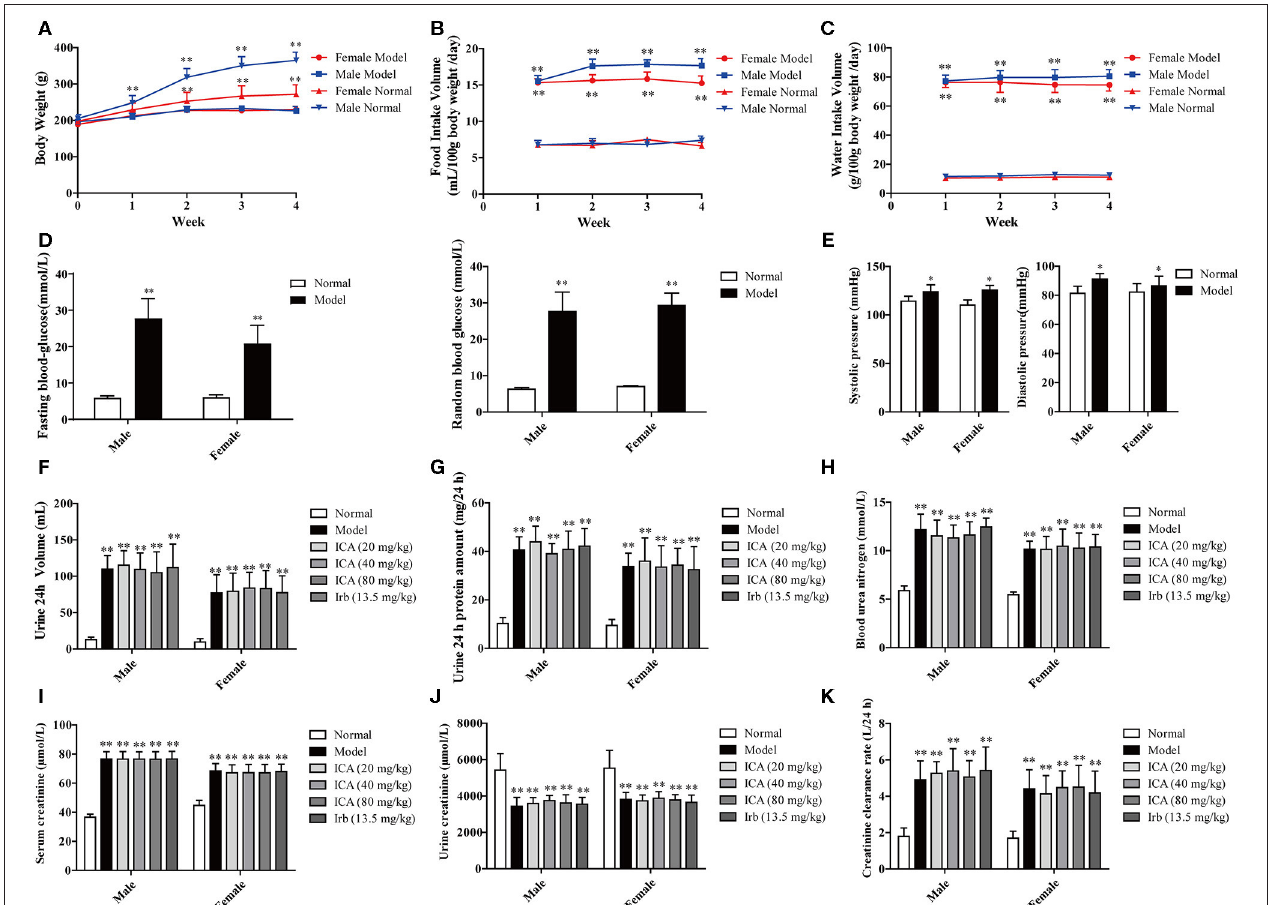
FIGURE 2 | Renal function in STZ-induced diabetic rats before administration. Four weeks after STZ administration, diabetic nephropathy models were examined based on general indicators. (A) Weight loss. (B) Food intake. (C) Water intake. (D) Blood glucose. (E) Blood pressure. (F) 24h urine volume, (G) 24h proteinuria, (H) Blood urea nitrogen (BUN), (I) Serum creatinine (Src), and (J) Urine creatinine (Ucr) were measured by ELISA. (K) Creatinine clearance rate. Data are expressed as mean ± SD. * p < 0.05, ** p < 0.01, compared with the normal group.